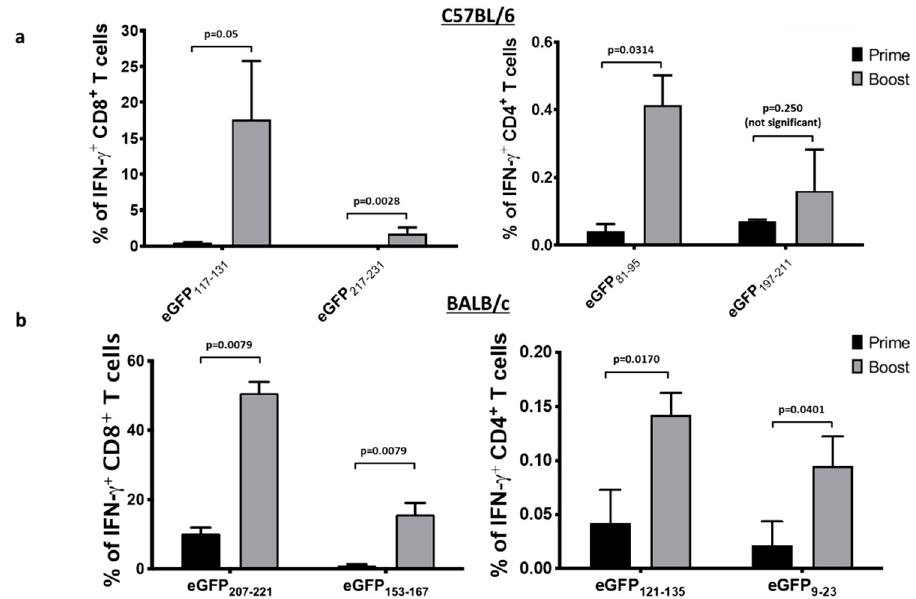
Figure 7. Prime-boosting against eGFP with Ad-eGFP and VSV-eGFP induced CD4 + and CD8 + T cell responses of high magnitude. ( a ) C57BL/6 and ( b ) BALB/c mice were vaccinated against eGFP by priming intramuscularly with Ad-eGFP at 1 × 10 8 ifu, and primary responses were assessed 10 days later. Mice were boosted intravenously with VSV-eGFP (1 × 10 9 pfu) 14 days post-Ad, and the secondary responses were assessed five days post-VSV. Graphs depict CD8 + (left) and CD4 + (right) T cell responses to the immunodominant and subdominant epitopes of eGFP via intracellular cytokine staining after peptide re-stimulation. Standard errors of the means are shown. Data represent n = 3 and n = 4 C57BL/6 and BALB/c mice per group, respectively.